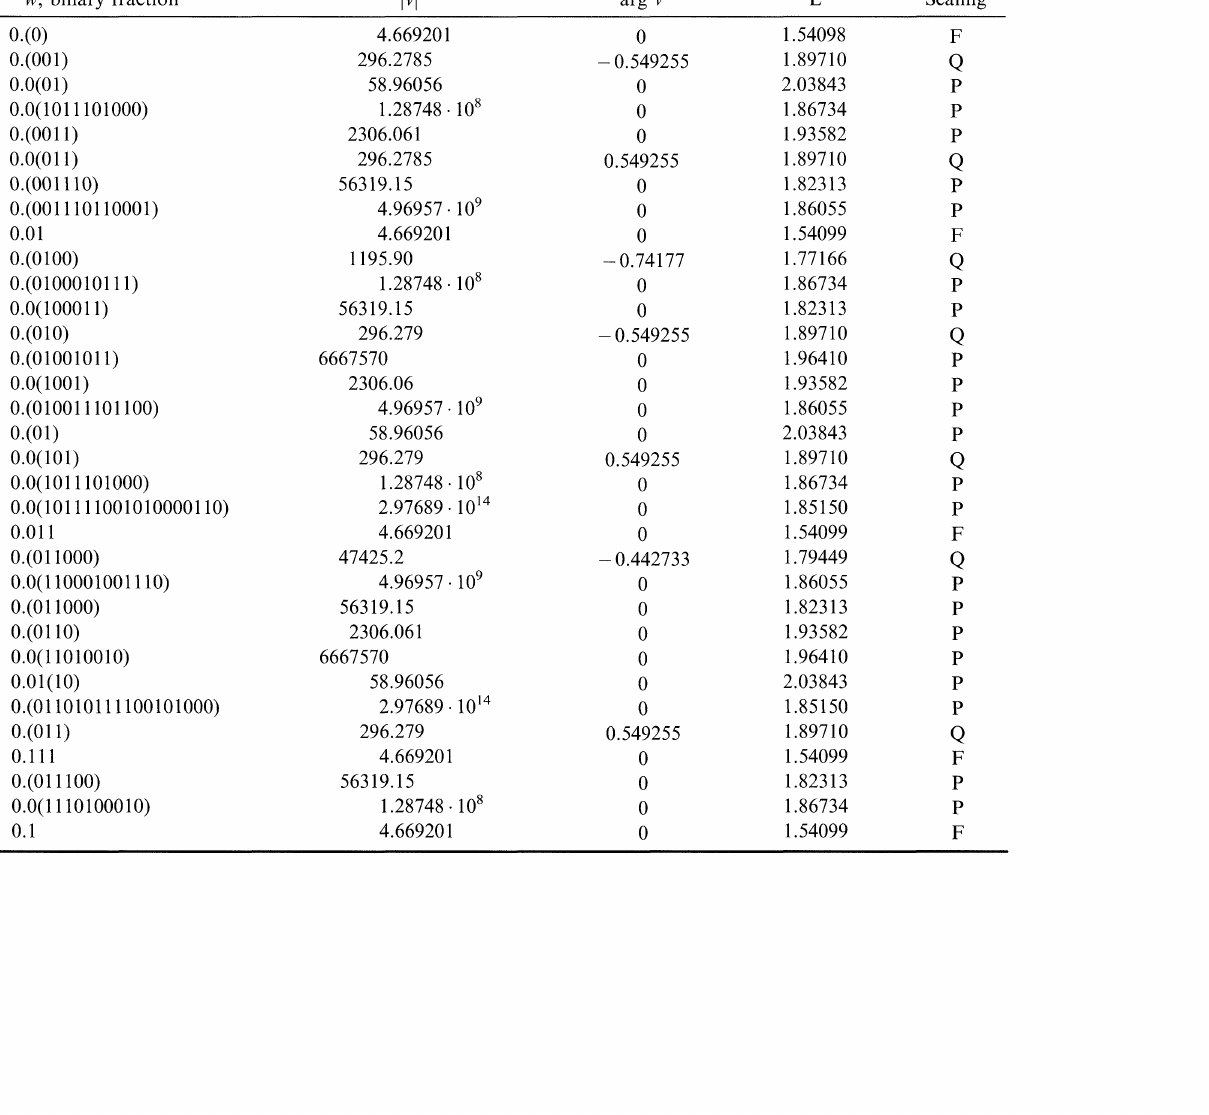
Eigenvalues of Eq. (12) and corresponding RGLE in dependence on the frequency parameter